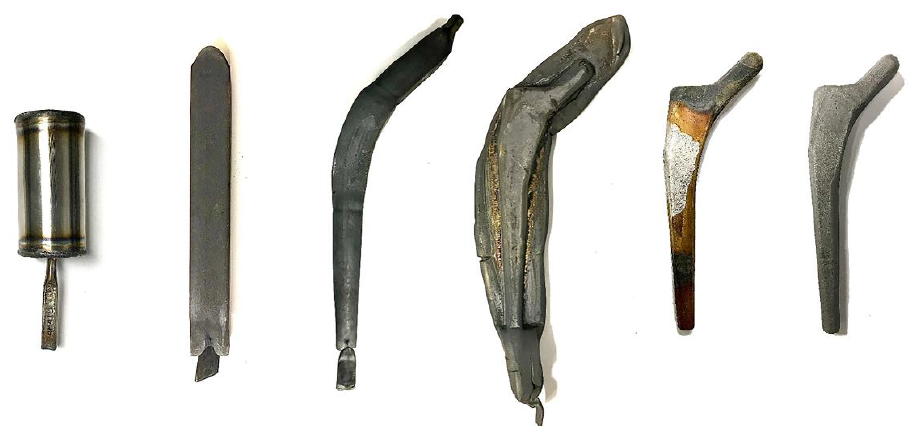
Figure 3. From left to right, photographs presenting the initial canister, the forged billet, the preform, the final precision forging, the cut-out sample and the sandblasted final component.